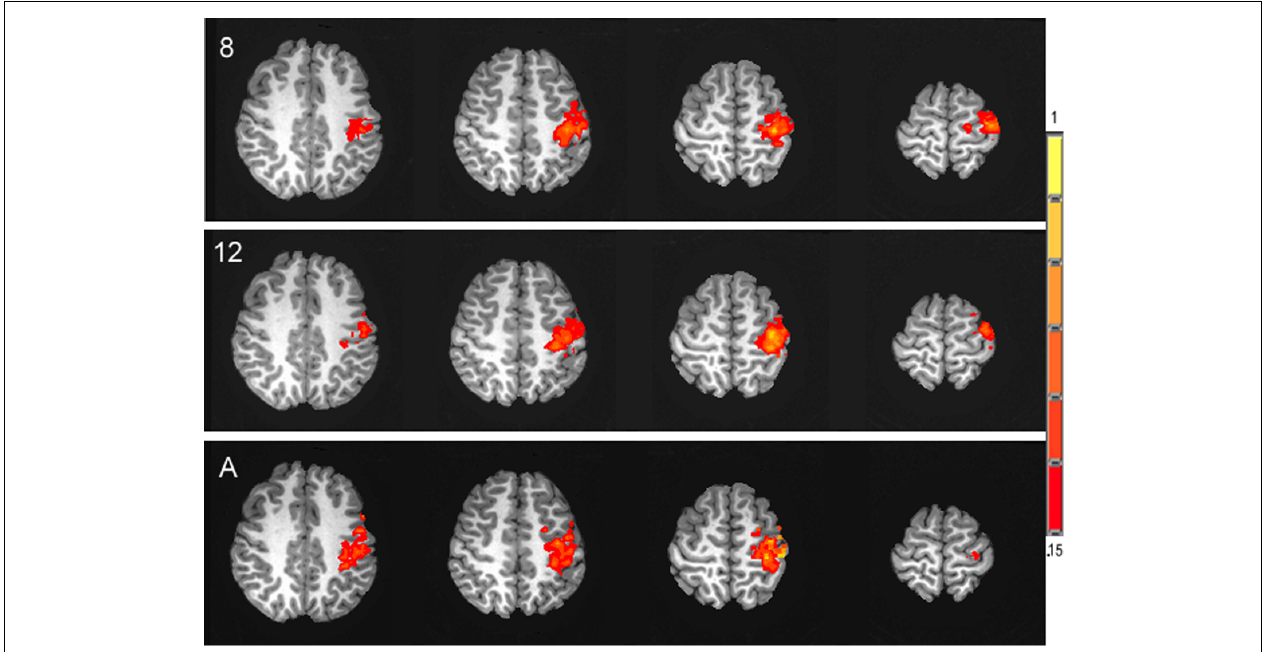
FIGURE 6 |Activation maps of the spatial distribution of the task-related BOLD response in each of the three age groups, 8 year olds (8), 12 year olds (12) and adults (A), presented in the axial plane in radiological orientation. Signal intensity is represented in the color scale.